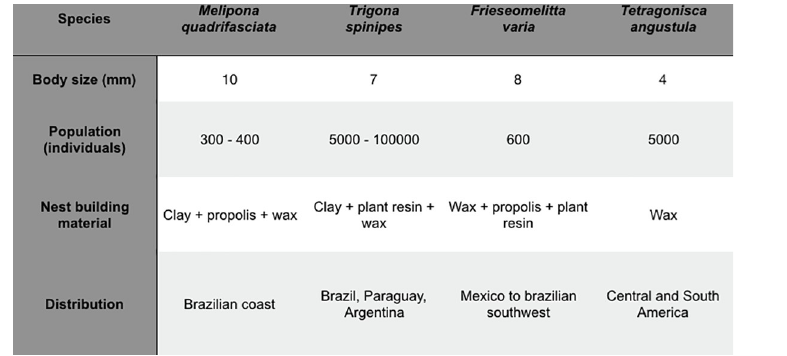
Fig 1. General information about Brazilian stingless